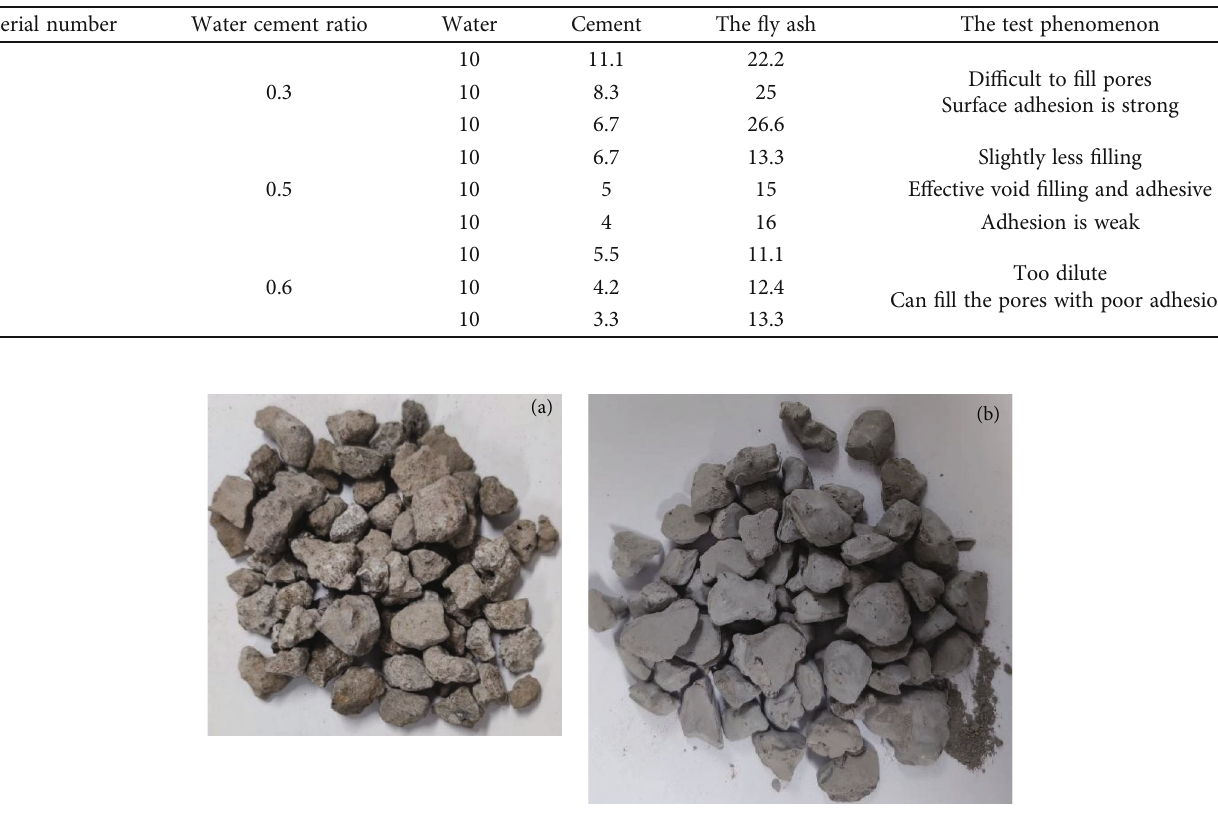
Table 1: Mixture ratio of modi fi ed slurry (kg).